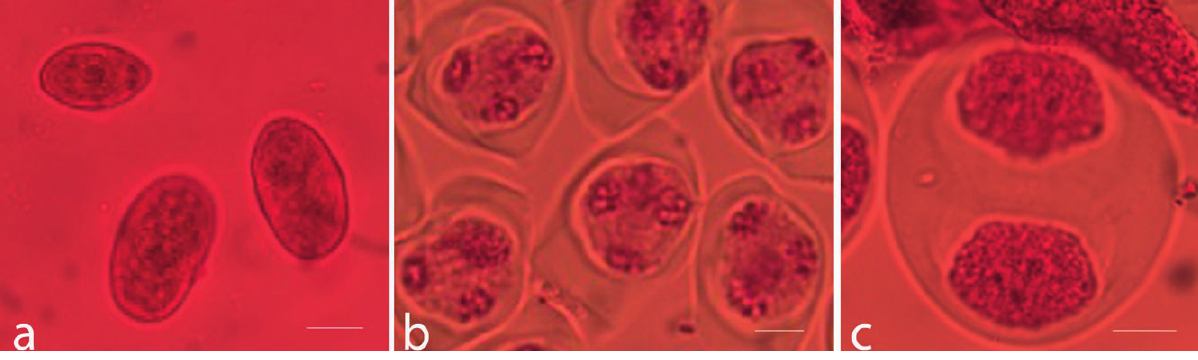
Figure 2. Example of pollen grains and PMCs at the sporad stage observed in plants producing large pollen. Pollen sample showing normal and large pollen grains (a); group of tetrads with four n (reduced) microspores (b); dyad containing two 2 n (unreduced) microspores (c). The bar represents 10